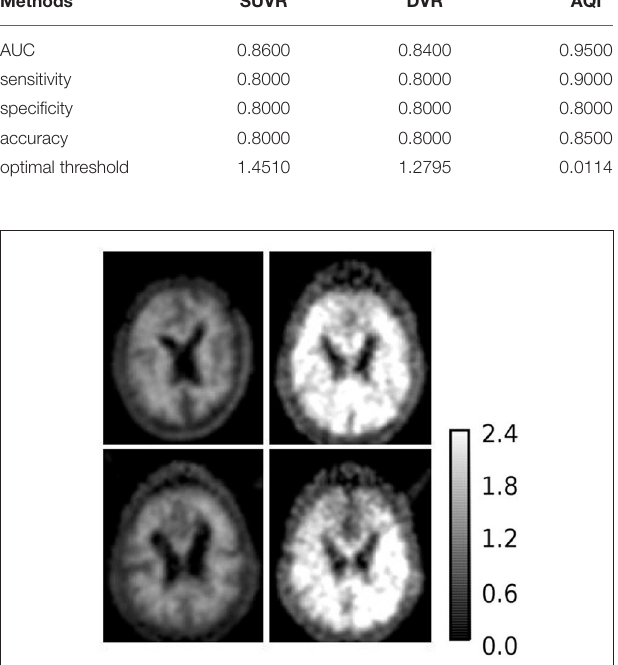
FIGURE 7 | SUVR images of example AD subjects (1) upper left: AD_038 (SUVR = 1.1207); (2) upper right: AD_001 (SUVR = 2.0235); (3) lower left: AD_040 (SUVR = 1.1699); (4) lower right: AD_005 (SUVR = 1.5531). AD_038 and AD_040 were misclassified as HC subjects by SUVR and DVR. AD_001 and AD_005 were correctly classified AD subjects by all three measures.